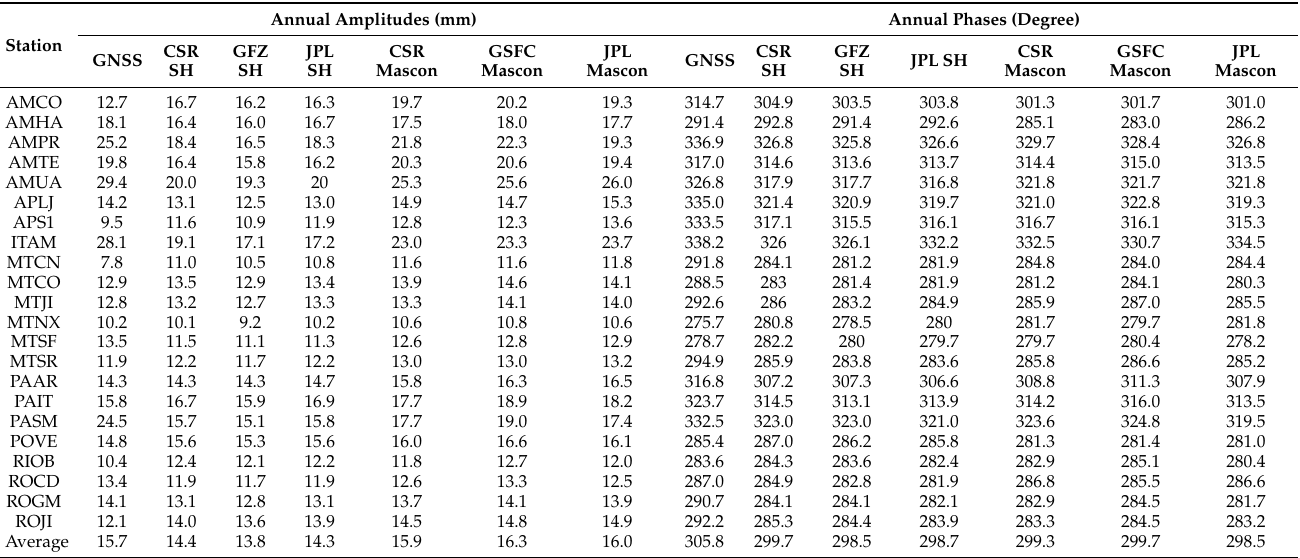
Table 2. The annual amplitudes and phases of GNSS solutions and 6 GRACE/GRACE-FO products derived displacements at the 22 GNSS